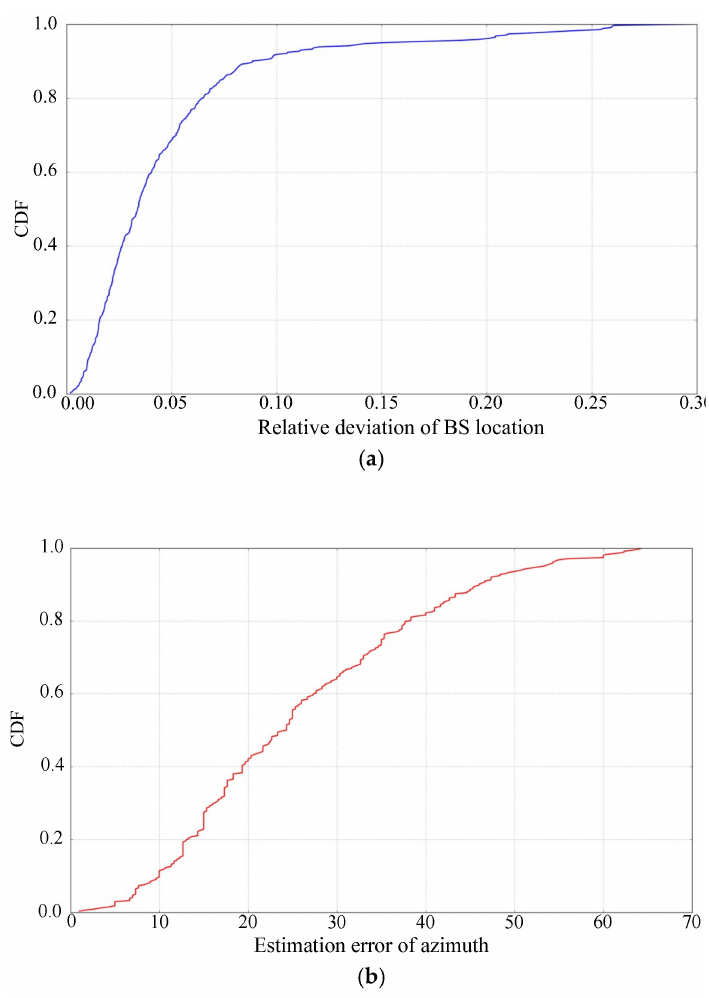
Figure 12. CDF of BSA estimation: ( a ) Relative deviation of BS location; ( b ) Estimation error of